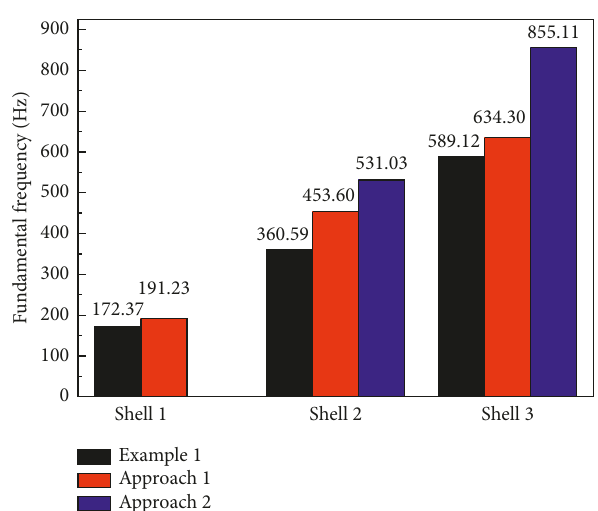
Figure 15: Comparison of optimal results by Approaches 1 and 2 and Example 1.